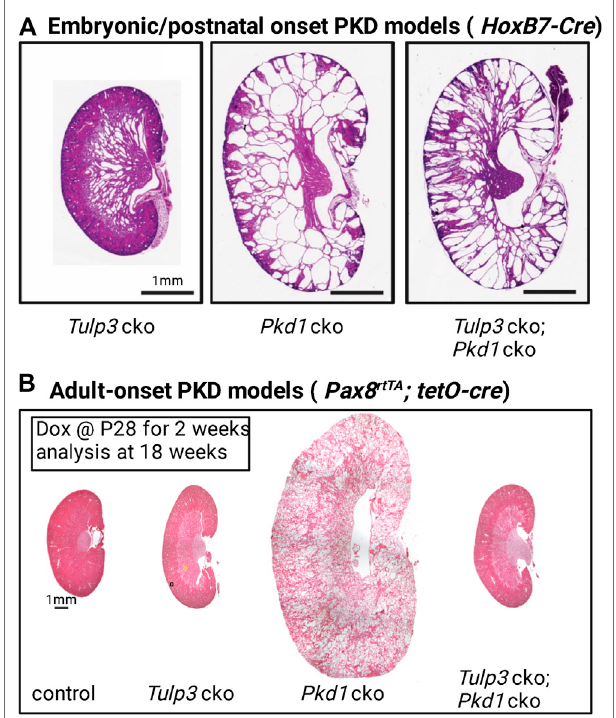
FIGURE 4 | Tulp3 and Pkd1 double knockout models of PKD. (A) Kidneys from postnatal day 5 (P5). Tulp3 cko ( HoxB7-cre; Tulp3 fl / fl ), Pkd1 cko ( HoxB7-cre;Pkd1 fl / fl ), Tulp3 cko; Pkd1 cko( HoxB7-cre;Tulp3 fl / fl ;Pkd1 fl / fl ).cko: conditional knockout. Scale bar, 1 mm. Images adapted from (Hwang et al., 2019). (B) Adult-onset models. Pax8 rtTA ; tetO -cre doxycycline inducible miceweregivendoxycycline(Dox)startingatP28for2weeksandanalyzedat 18 weeks. Control (mice without tetO -cre), Tulp3 cko ( Pax8 rtTA ; tetO-cre ; Tulp3 fl / fl ), Pkd1 cko ( Pax8 rtTA ; tetO-cre; Pkd1 fl / fl ), Tulp3 cko; Pkd1 cko ( Pax8 rtTA ; tetO-cre; Tulp3 fl / fl ;Pkd1 fl / fl ). Images adapted from (Legue and Liem, 2019) with